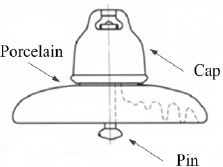
Figure 3. Structure of a cap and pin insulator.